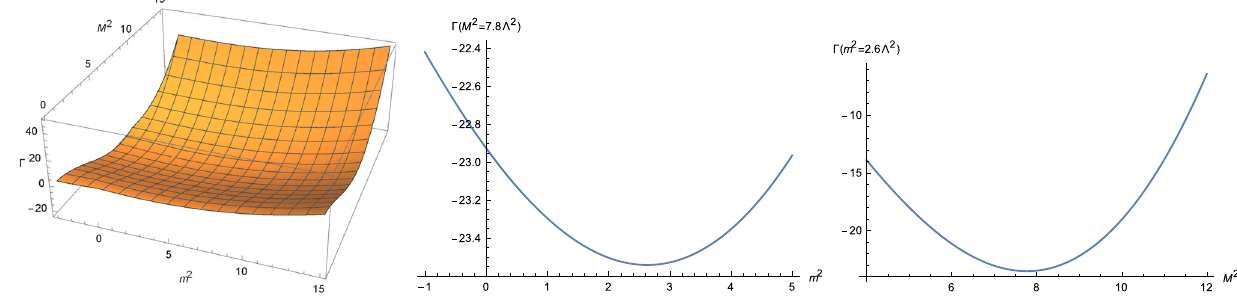
Fig. 1 The effective action (left) and 2 slices thereof illustrating the minimum (right) ( N = 3 case, in units of (cid:25)